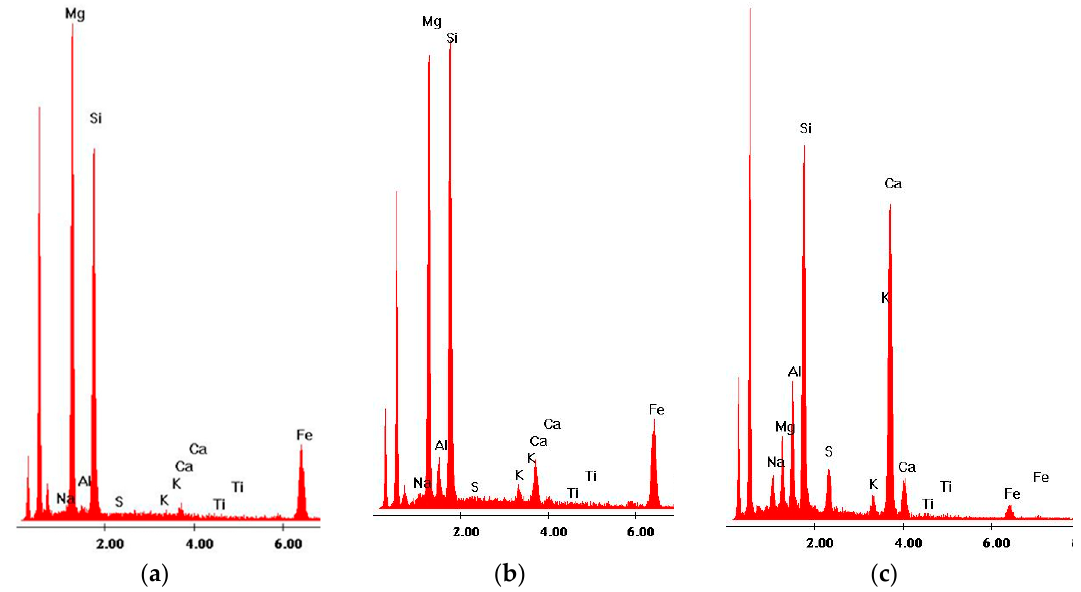
Figure 11. X-ray analysis in the micro-areas indicated in Figure 10: ( a ) olivine crystal—point 1, ( b ) and ( c ) thin layer of C–S–H phase on olivine grain—points 2 and 3.